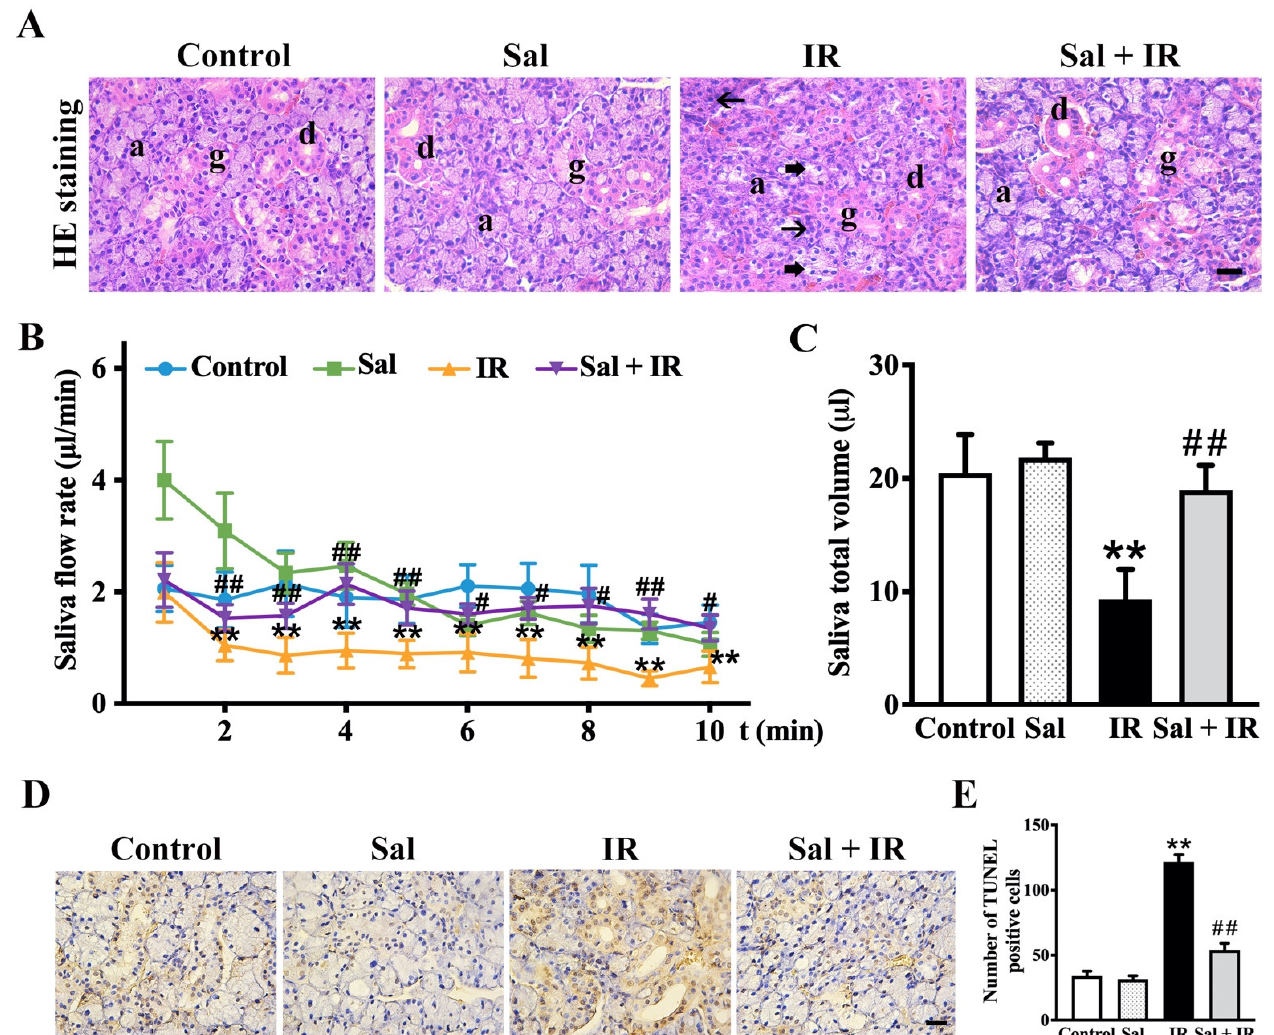
Figure 6. Salidroside alleviated radiation damage and promoted saliva secretion in rat SMG tissues. ( A ) Representative images of rat SMG tissues with HE staining (bar = 25 μm, n = 6 for each group). Thin arrows represent atrophy in acinar cells, and thick arrows represent vacuolar degeneration in GCT cells and acinar cells. Abbreviations: a, acinar cell; d, ductal cell; g, granular convoluted tubule cell. ( B ) Analysis of the saliva flow rate and ( C ) saliva bulk volume in pilocarpine-stimulated rat SMGs. The data are shown as the mean ± SEM ( n = 6 for each group). ( D ) Representative images of apoptotic cells in irradiated SMGs ( n = 6 for each group). Brown nuclei indicate positive staining (bar = 25 μm). ( E ) Analysis of the number of TUNEL-positive cells in ( D ). ** p < 0.01 vs. the controls. # p < 0.05 and ## p < 0.01 vs. irradiation alone.